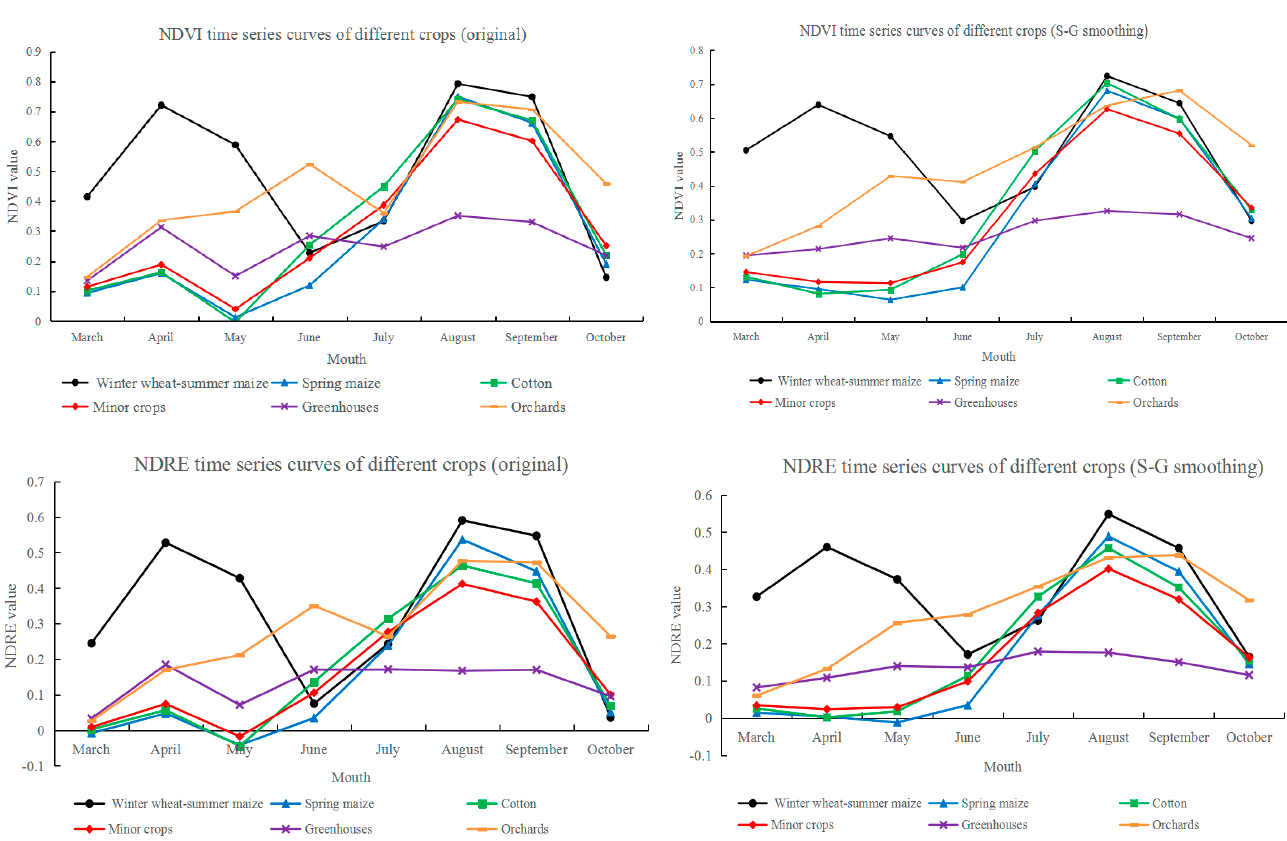
Figure 4. Comparison of NDVI and NDRE time series curves about different crops.